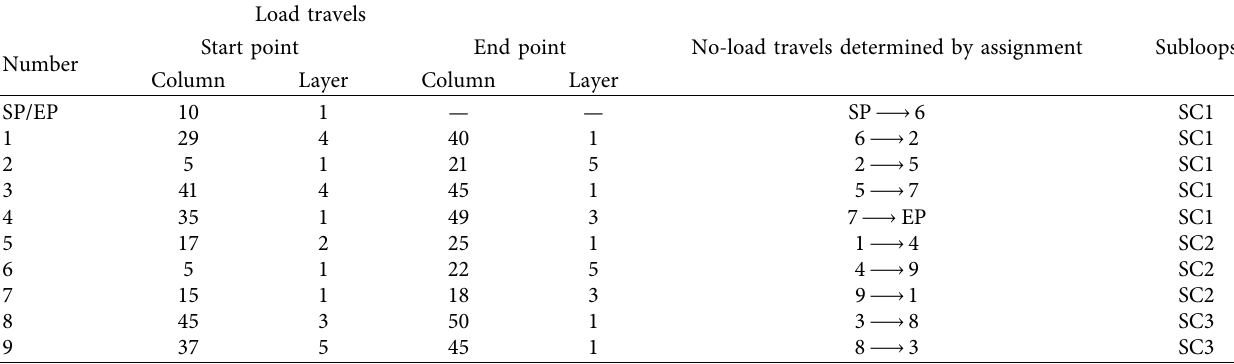
Table 3: An example of the suboptimal solution of TSP obtained by minimum cost